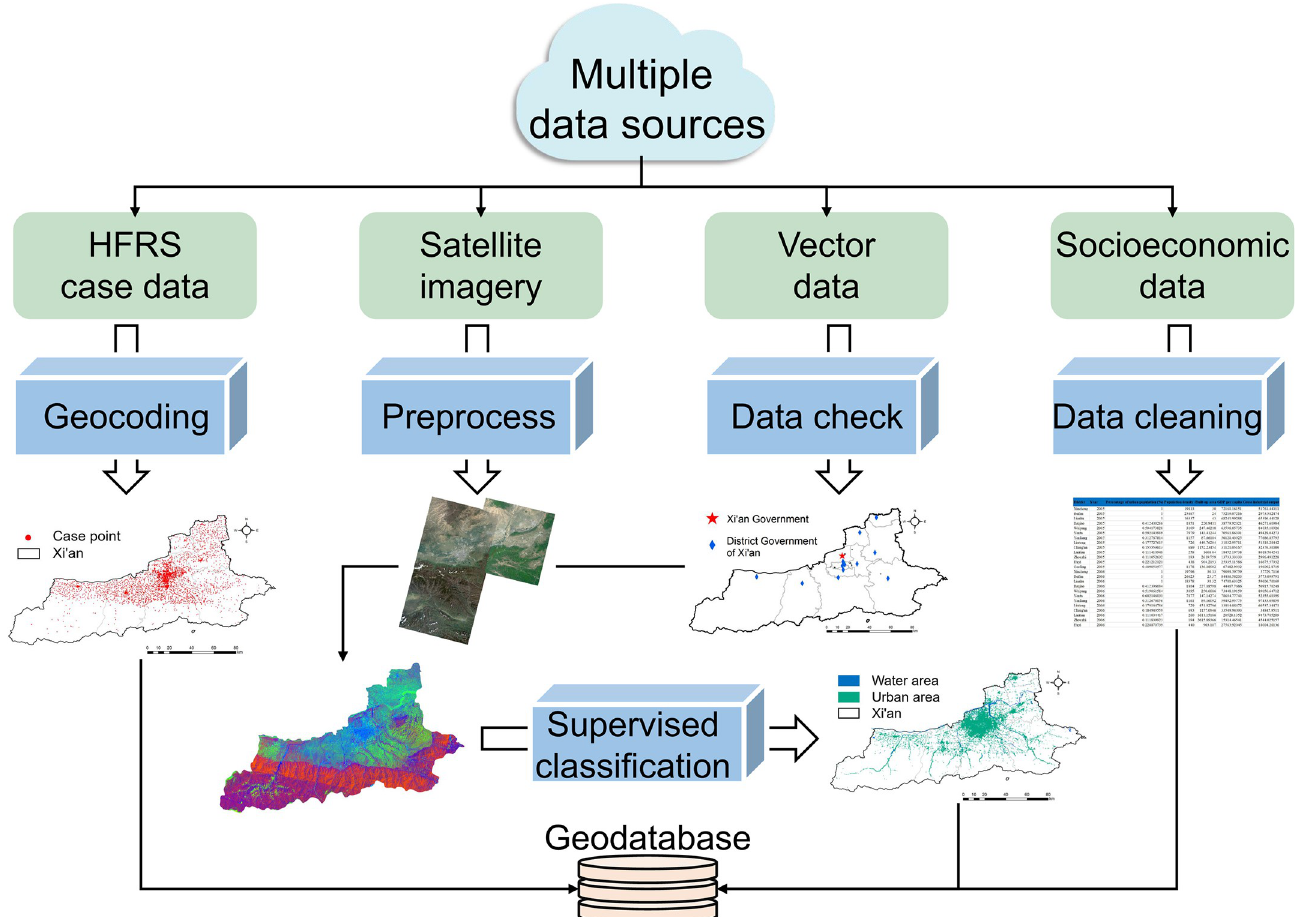
Fig 1. Multiple data sources and establishment of a geodatabase. The maps in the figure were produced in ArcGIS 10.8 (ESRI, Redlands, CA, USA) using shape files representing Xi’an City which were obtained from the basic geographic database in National Catalogue Service For Geographic Information of China